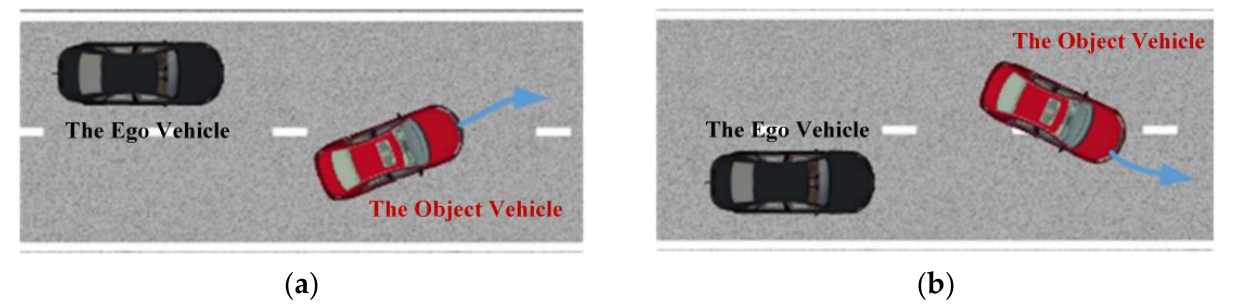
Figure 10. The ODD of the cut-in scenario. The red vehicle denotes the object vehicle and the black one denotes the ego vehicle. ( a ) The object vehicle cuts into the right lane of the ego vehicle; ( b ) the object vehicle cuts into the left lane of the ego vehicle.